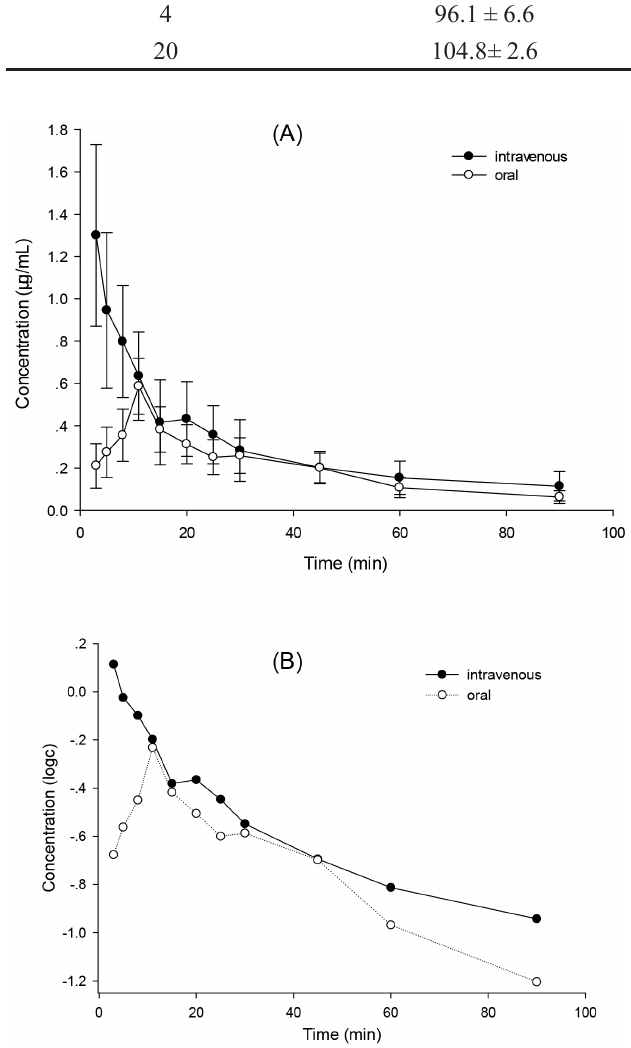
FIGURE 5 - Mean plasma concentration-time curves of hydroxydihydrobovolide in rats ( n = 5) after the intravenous and oral administration at dose of 5.9 mg/kg and 78.9 mg/kg, respectively. Figure A: c-t; Figure B: logc-t.